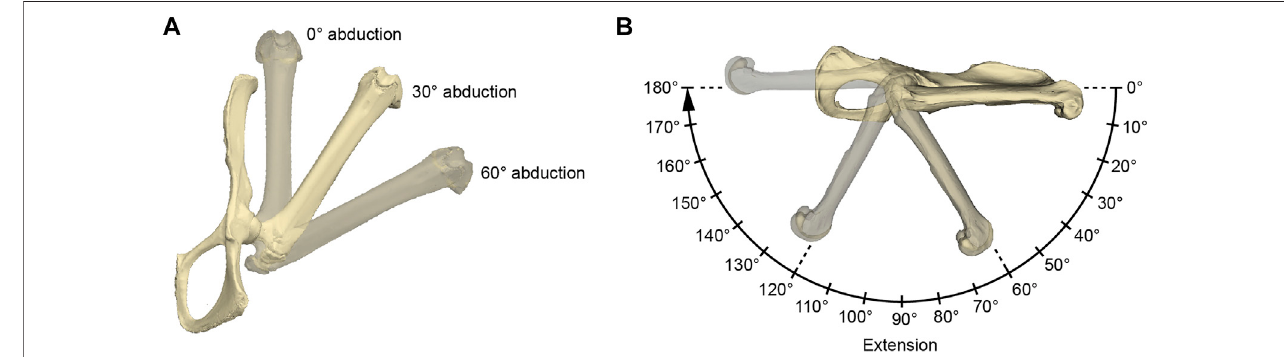
FIGURE 3 | Illustration of the acquired hip joint angles. (A) Three abduction angles were used for each measurement series of extension angles (B) . The here depictedextensionangleis0 ° . (B) Procedureofasinglemeasurementseries.The0 ° rotationalangleinthe0 ° abductionsettingasin (A) wasusedasthereferencepose. The IMMAs were measured every 10 ° resulting in 19 values per abduction setting and 54 values per specimen in total. For further explanation, see